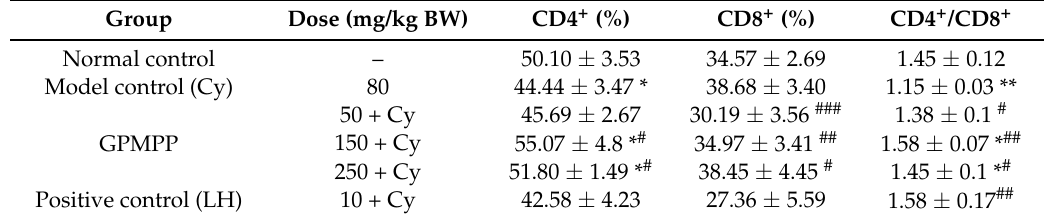
Positive control